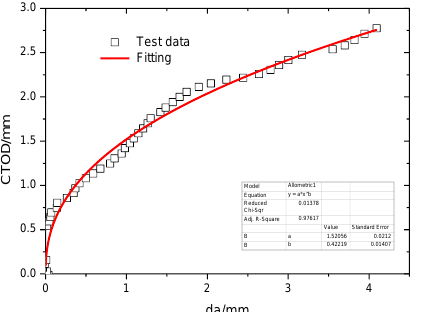
Figure 7. Crack growth resistance of the specimen (notch depth is 8.4 mm) by SENT. The fitting function in Figure 7 is